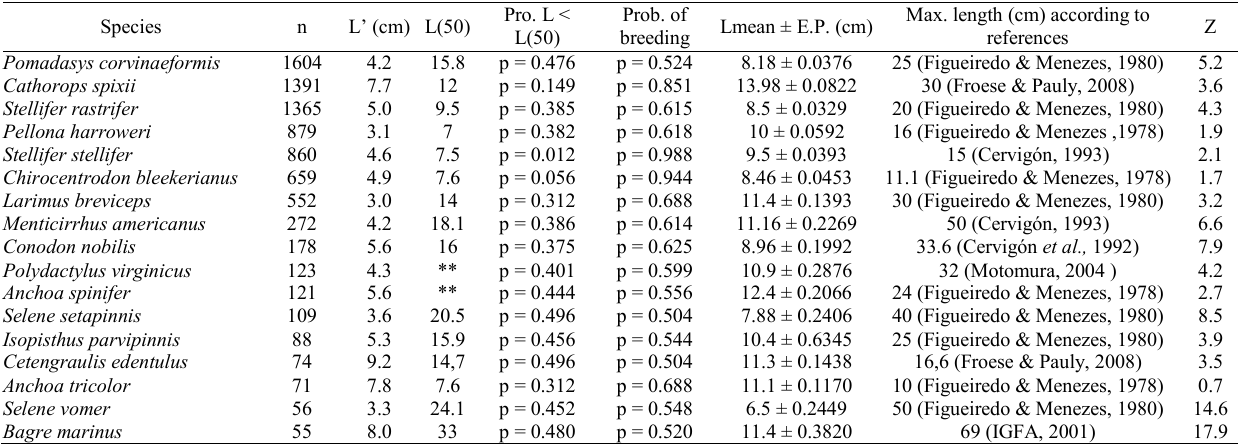
Table 3. Lengths of first capture and maturity, probabilities of caught below the length at maturity and breeding, mean and maximum length, and the mortality index of bycatch species at the São Cristóvão beach (RN). Legend: ** not found in the literature, size of sexual maturity. n - Number of individuals, L’ - length at first capture, L(50) - length at first maturity, Prob. - probability, Z - mortality index.